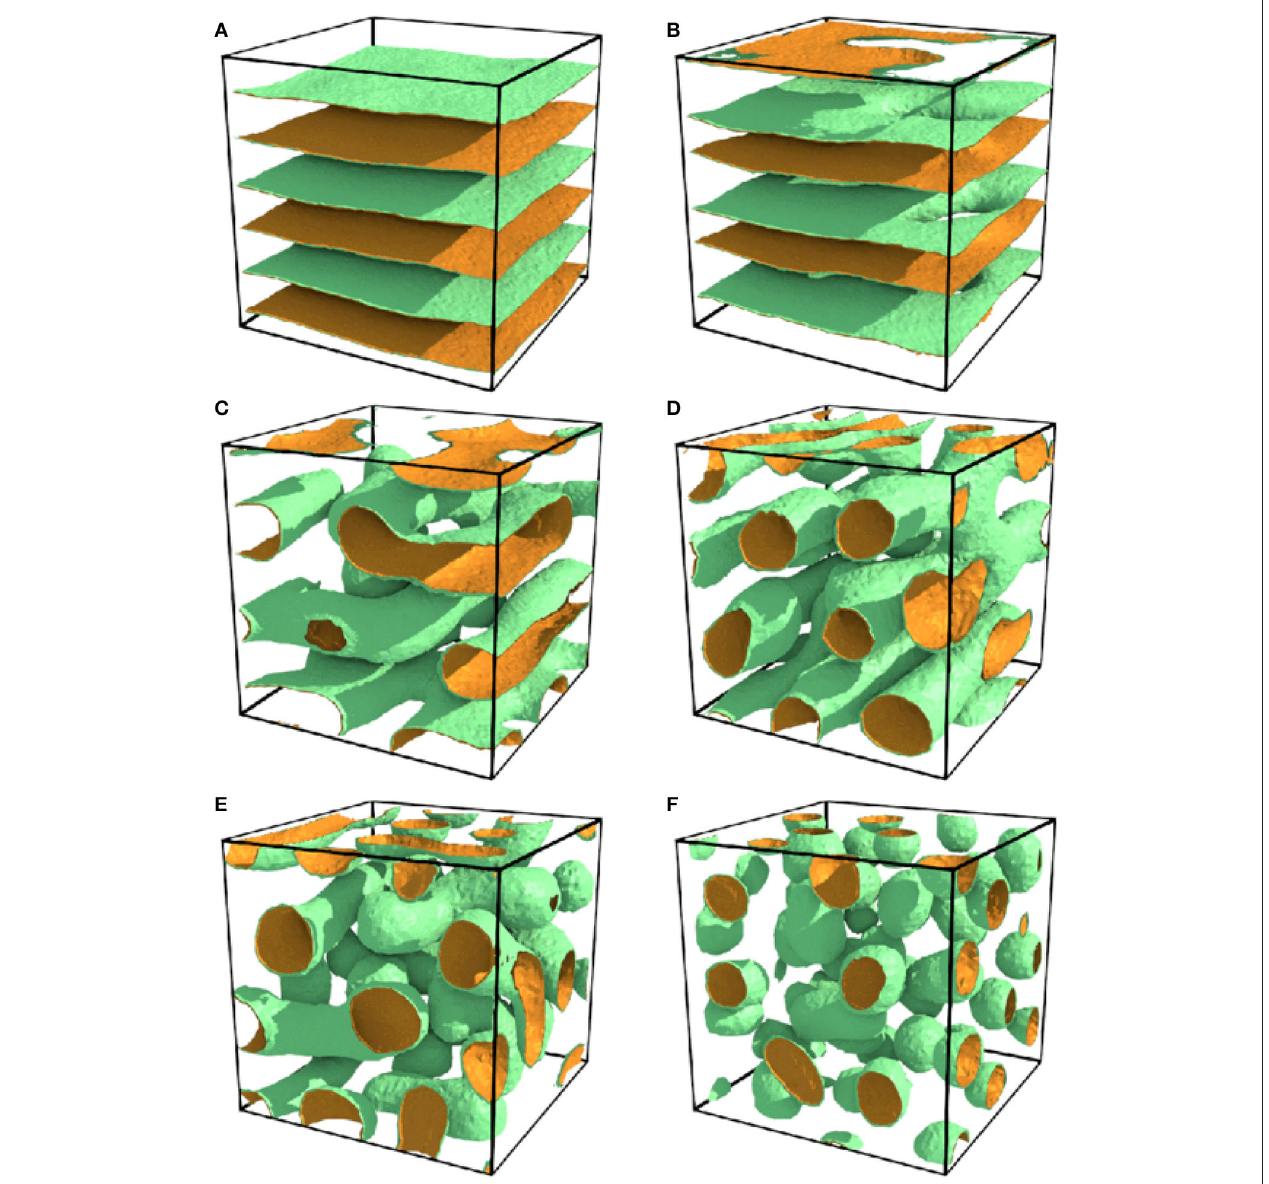
FIGURE 6 | Ordered structures of water/organic solvent/antagonistic salt mixtures obtained by lattice-based Monte Carlo simulation. (A) Lamellar at x B = 0.5, (B) perforated lamellar at x B = 0.4, (C) tubular lamellar at x B = 0.3 (lower temperature region), (D) tubular at x B = 0.35, (E) tubular disordered at x B = 0.3 (higher temperature region), and (F) droplet phases at x B = 0.2. The figure is reproduced from Tasios et al. [34] with permission from Copyright 2017 by The American Physical